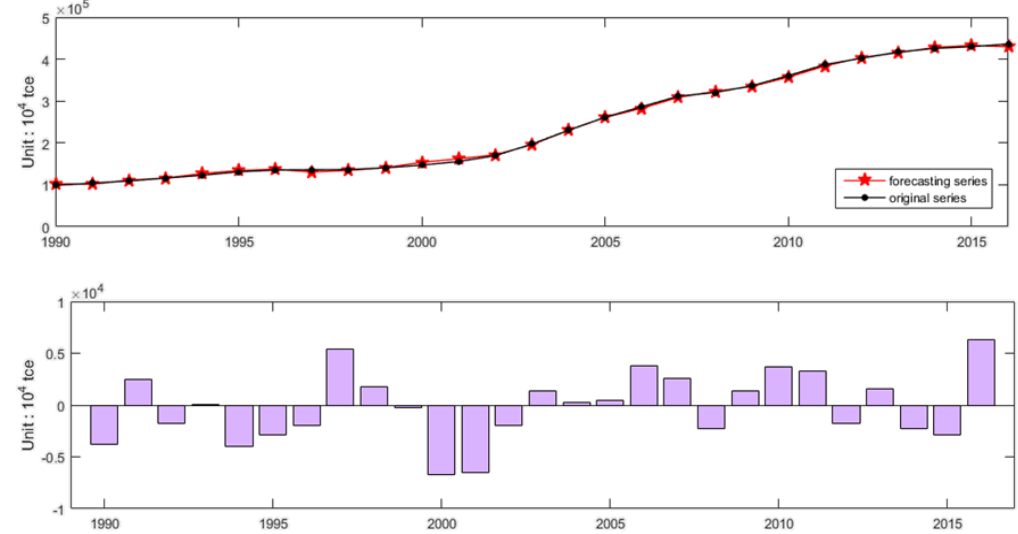
Figure 7. The prediction and residual figures of the final prediction result.